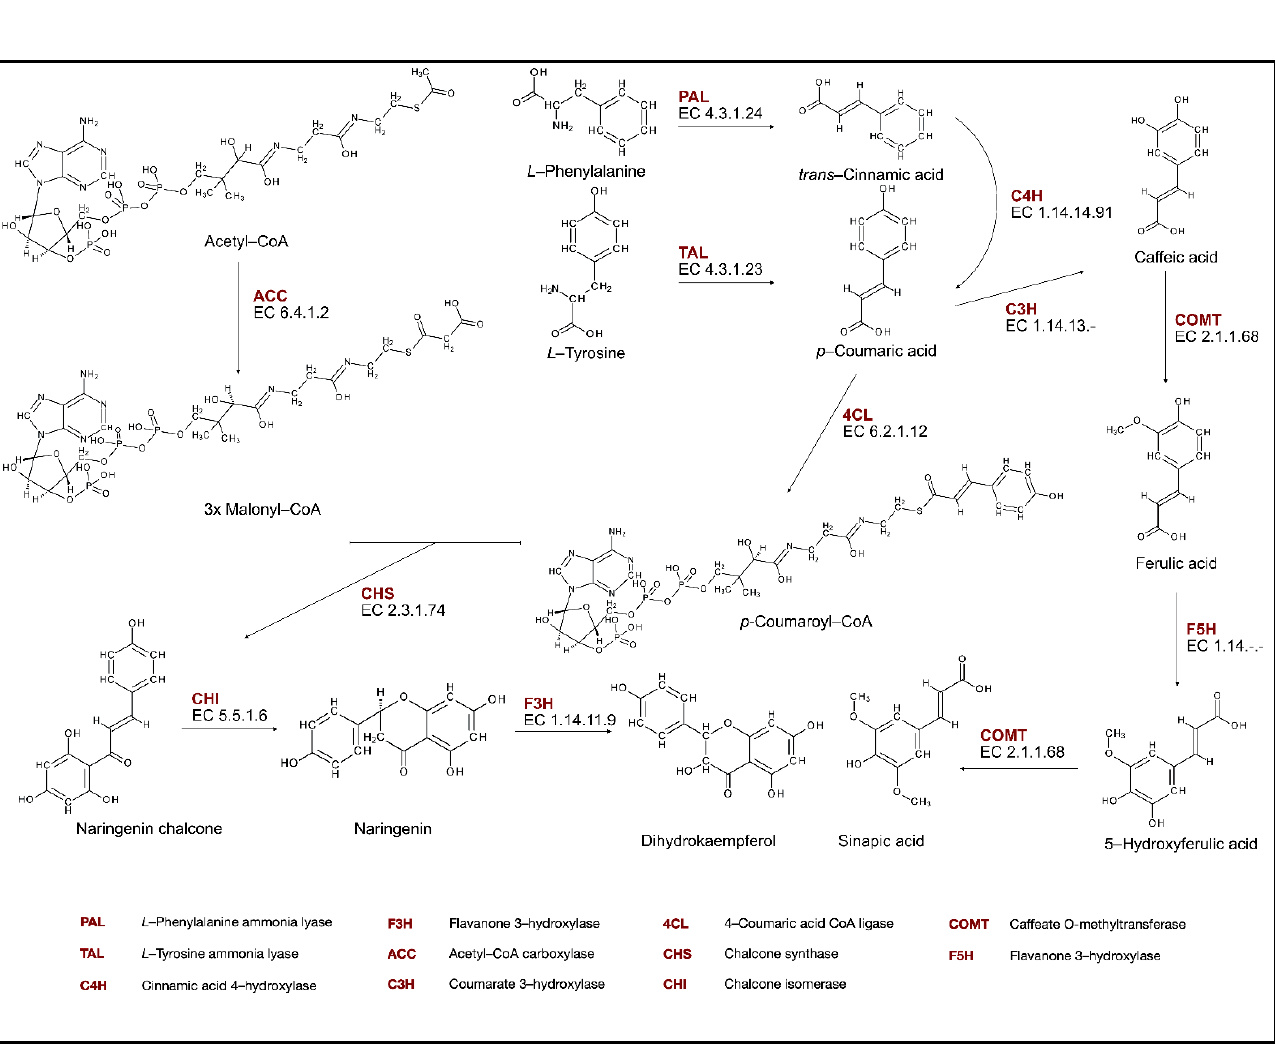
Figure 1. Phenolic compounds biosynthesis pathway.